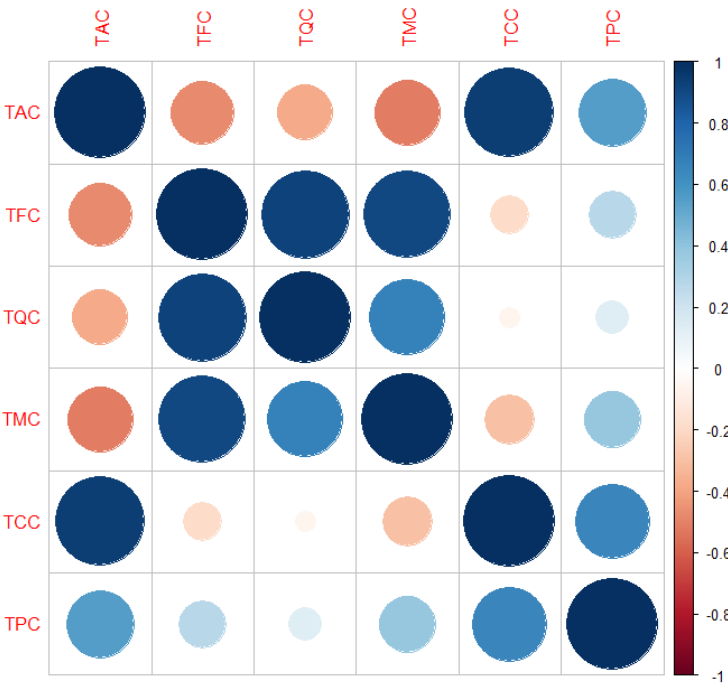
Figure 1. Correlation boxplot between identified and quantified compounds.